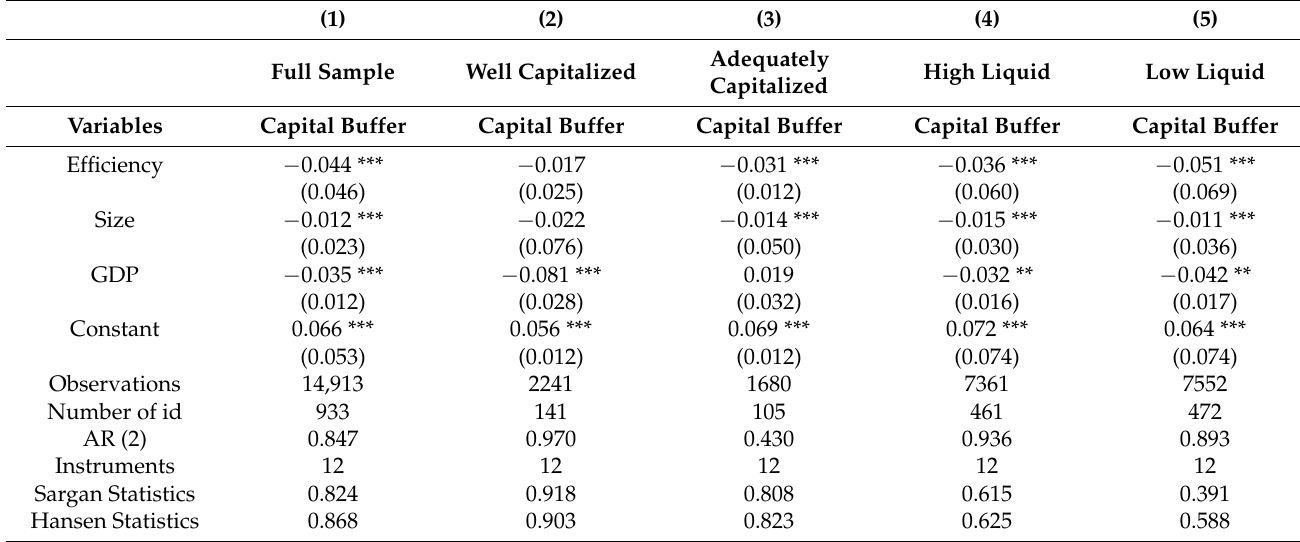
Table 3 used a two-step GMM method to measure the impact of macroeconomic fluctuation on banks’ capital buffer (ratio of risk-based capital to risk-weighted assets minus 8%) adjustment for the full sample, well, adequately, highly liquid, and low-liquid banks. If the overall risk-based capital ratio (tier I + II/total risk-weighted assets ratio) of banks is 10% or above is well-capitalized, if the ratio is between 8 to 10% then they are adequately capitalized banks. Based on their median value, commercial banks are classified as highly liquid or low-liquid banks. Banks with a higher ratio of liquid assets to deposits and short-term funding than the median are treated as highly liquid banks and low-liquid banks otherwise. Robust standard errors are reported in parentheses. *** and ** represent statistical significance at 1 and 5%,